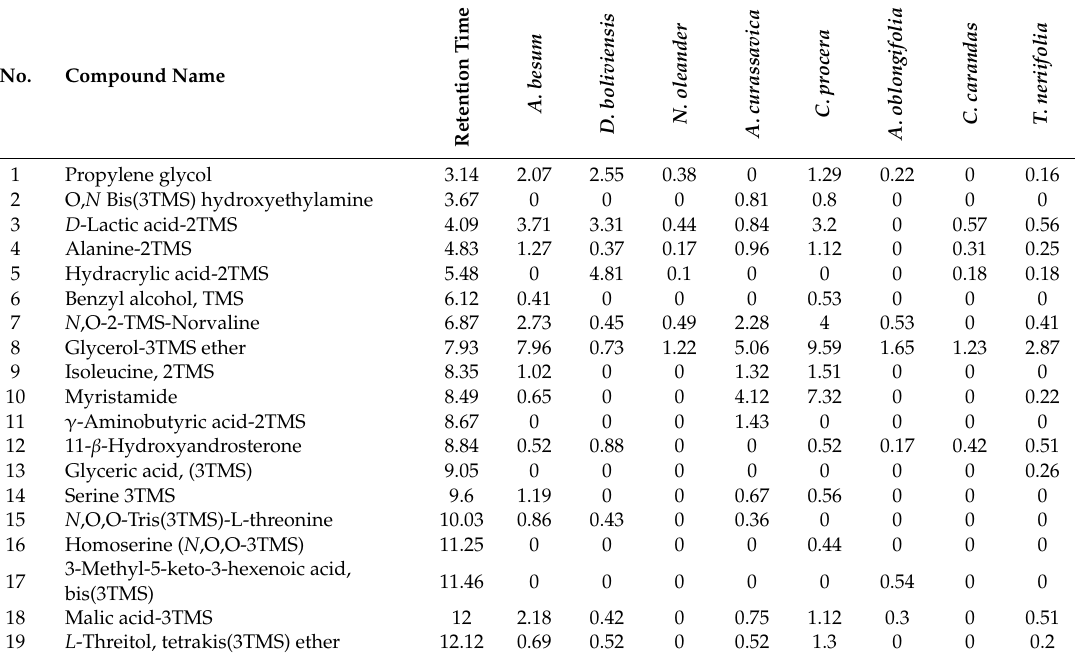
Table 1. The relative percentage of silylated metabolites of eight taxa of Apocynaceae derived via GC-MS.